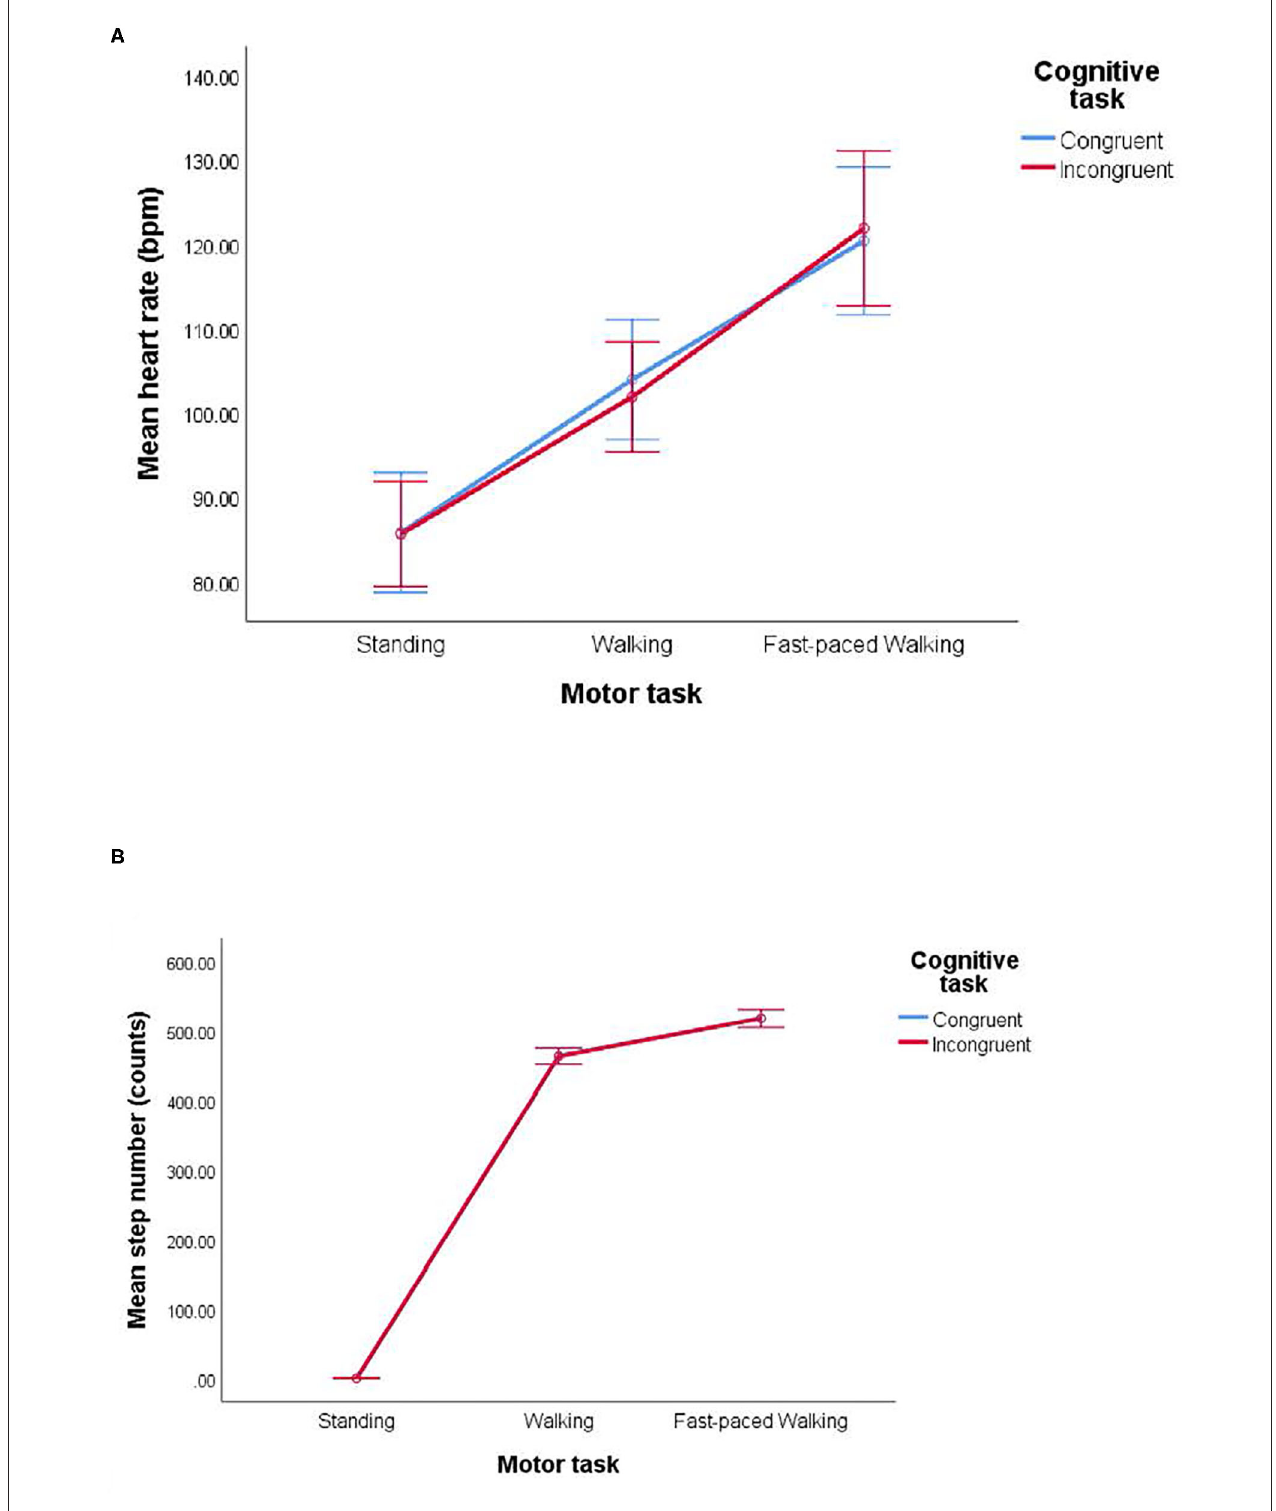
FIGURE 3 | Physiological responses of (A) heart rates and (B) step counts during VR dual-tasking conditions.